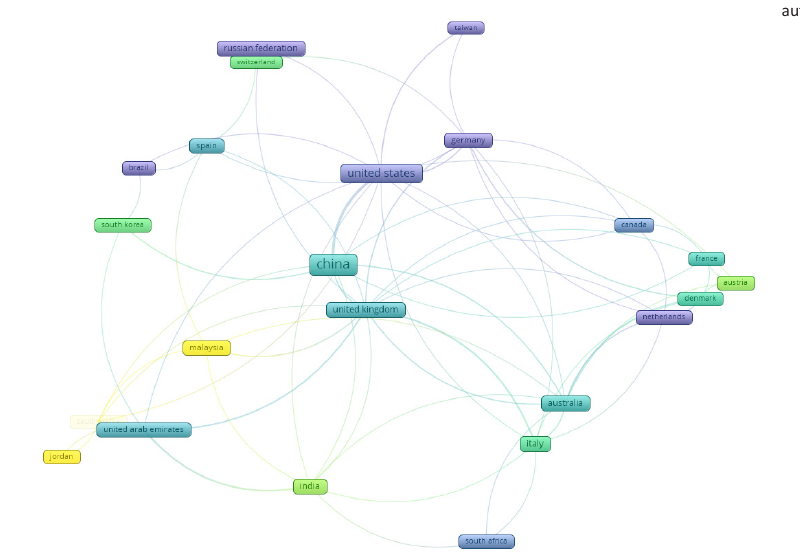
Figure 7. Spatial component of the bibliometric analysis of “blockchain” AND “accounting”